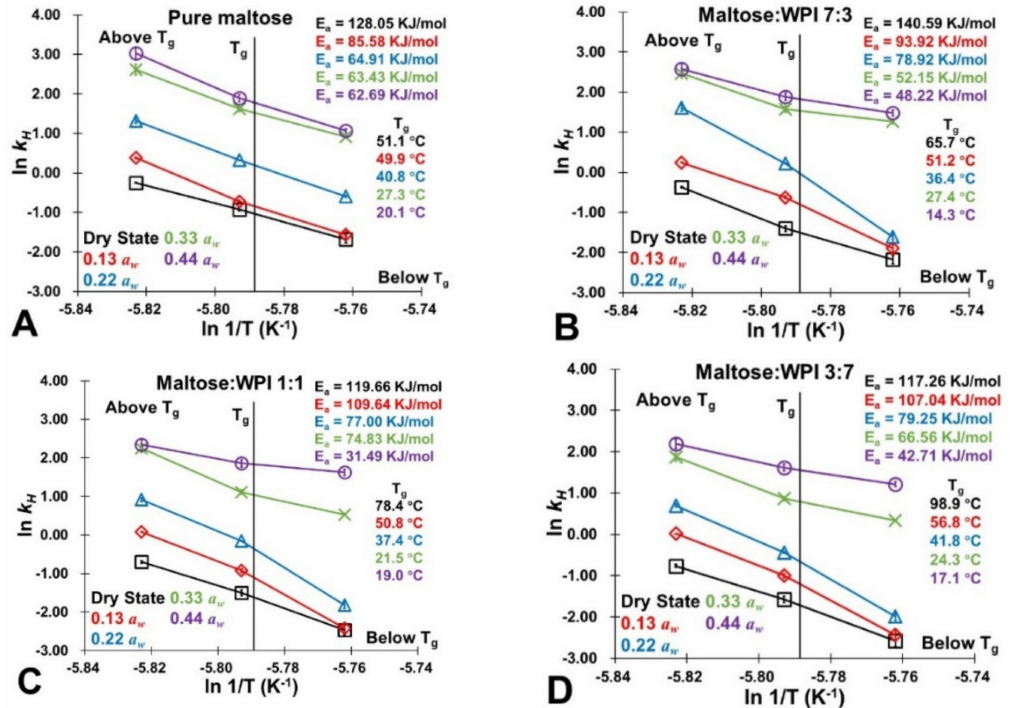
Figure 5. The Arrhenius plots of amorphous maltose and maltose/WPI mixtures after storage at the studied conditions (dry state~0.44 a w and 45~65 ◦ C). The activation energies ( E a ) were calculated based on k H values and the literature T g value of pure maltose was shown [23]. ( A ) Pure maltose; ( B ) Maltose:WPI 7:3; ( C ) Maltose:WPI 1:1; ( D ) Maltose:WPI